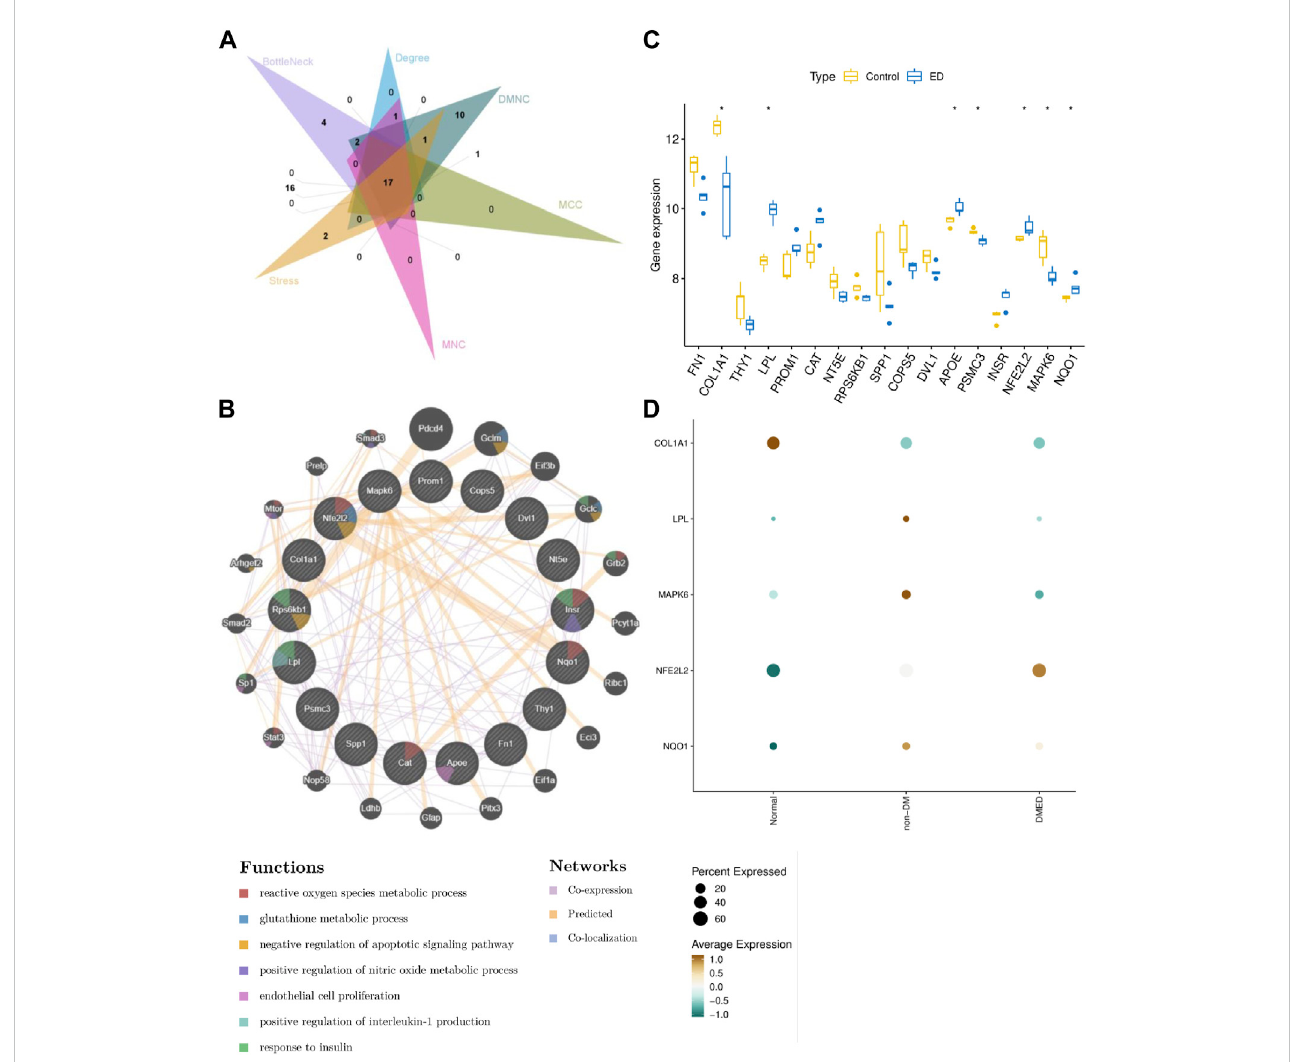
FIGURE 5 Analysis of comprehensive signature of signi fi cant CPRGs (A) The intersection of genes via six topological ranking algorithms in Cytohubba. (B) The interactioninformationforCPRGsinGeneMANIA. (C) TheexpressedpatternofCPRGsbetweenEDandcontrolgroups. (D) TheexpressedpatternofCPRGsin clinicalpatientswith impaired erectile function. For (B) , the20 mostfrequently changedneighboringgenes areshown. The associated neighboringgenes are in the outer circle and CPRGs in the inner circle. CP, chronic prostatitis; CPPS, chronic pelvic pain syndrome; CPRGs, CP/CPPS-related genes; ED, erectile